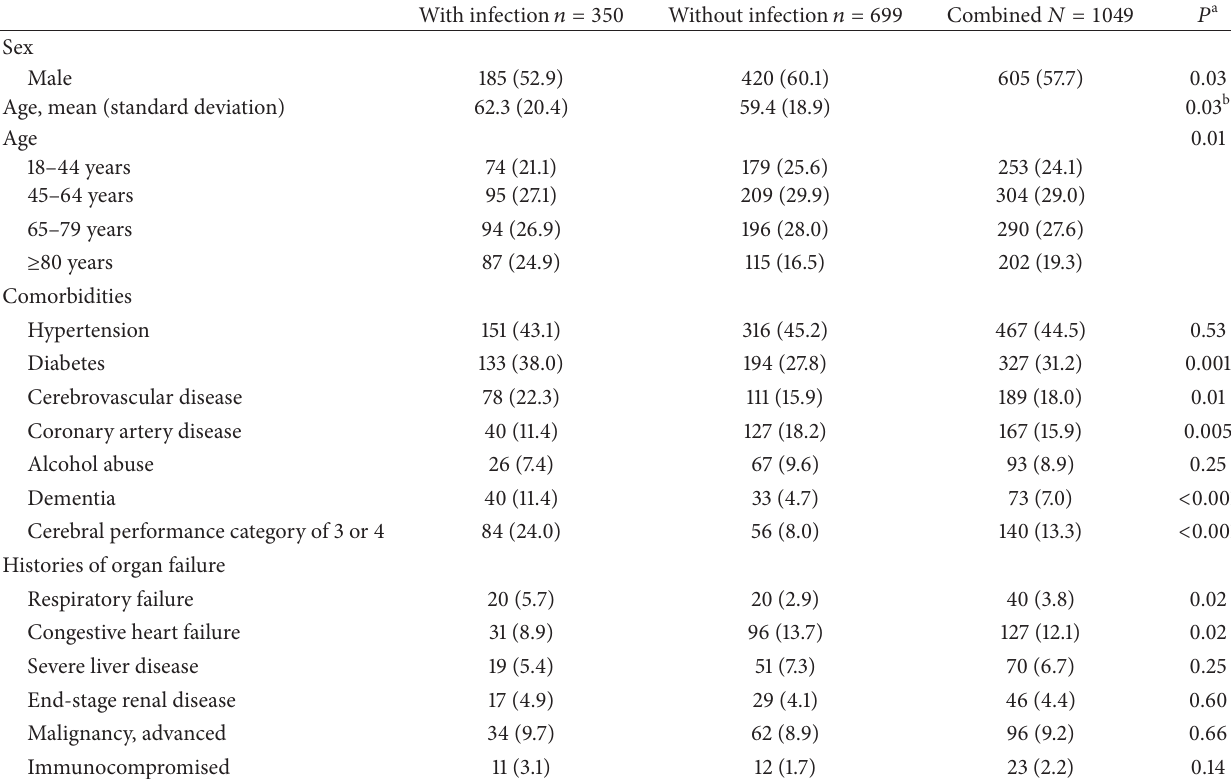
Table 1: Demographics and comorbidities in patients with infections and those without